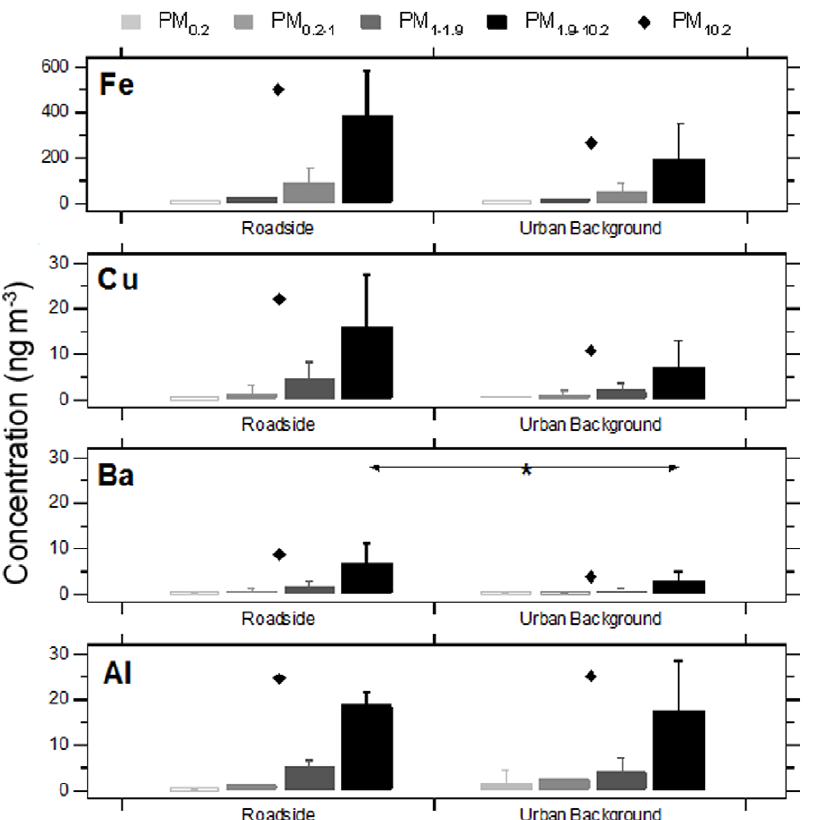
Figure 2. Mean size-fractionated PM trace metal (Fe, Cu, Ba, Al) concentrations at primary schools grouped by roadside and urban background site types. Each bar represents the mean and associated standard deviation. Diamond markers indicate the mean total PM 10.2 trace metal concentration for each site. Comparison of roadside and urban background means between PM size fractions was performed using a one-way ANOVA with post-hoc testing using the Tukey HSD test. Significant contrast (p , 0.05) are noted.